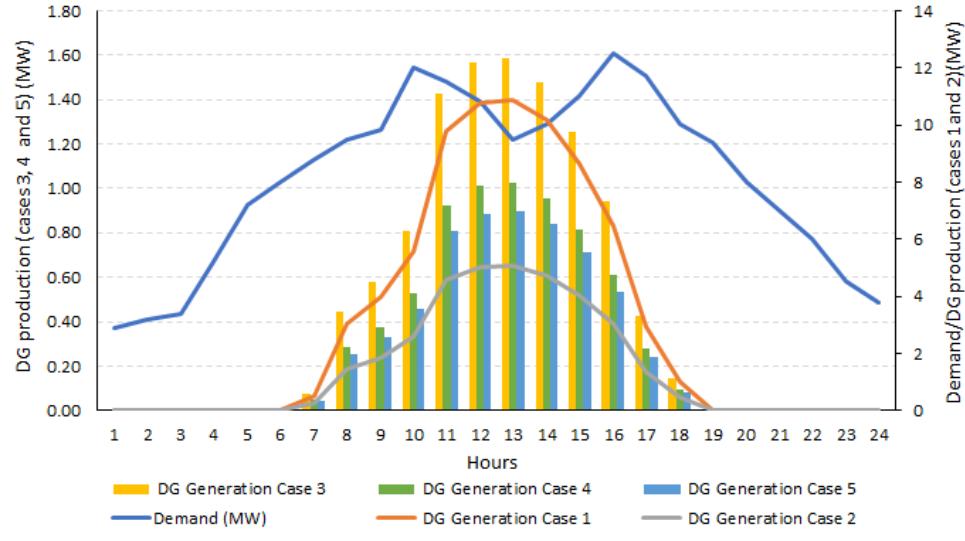
Figure 5. DG generation and demand at generation cases.